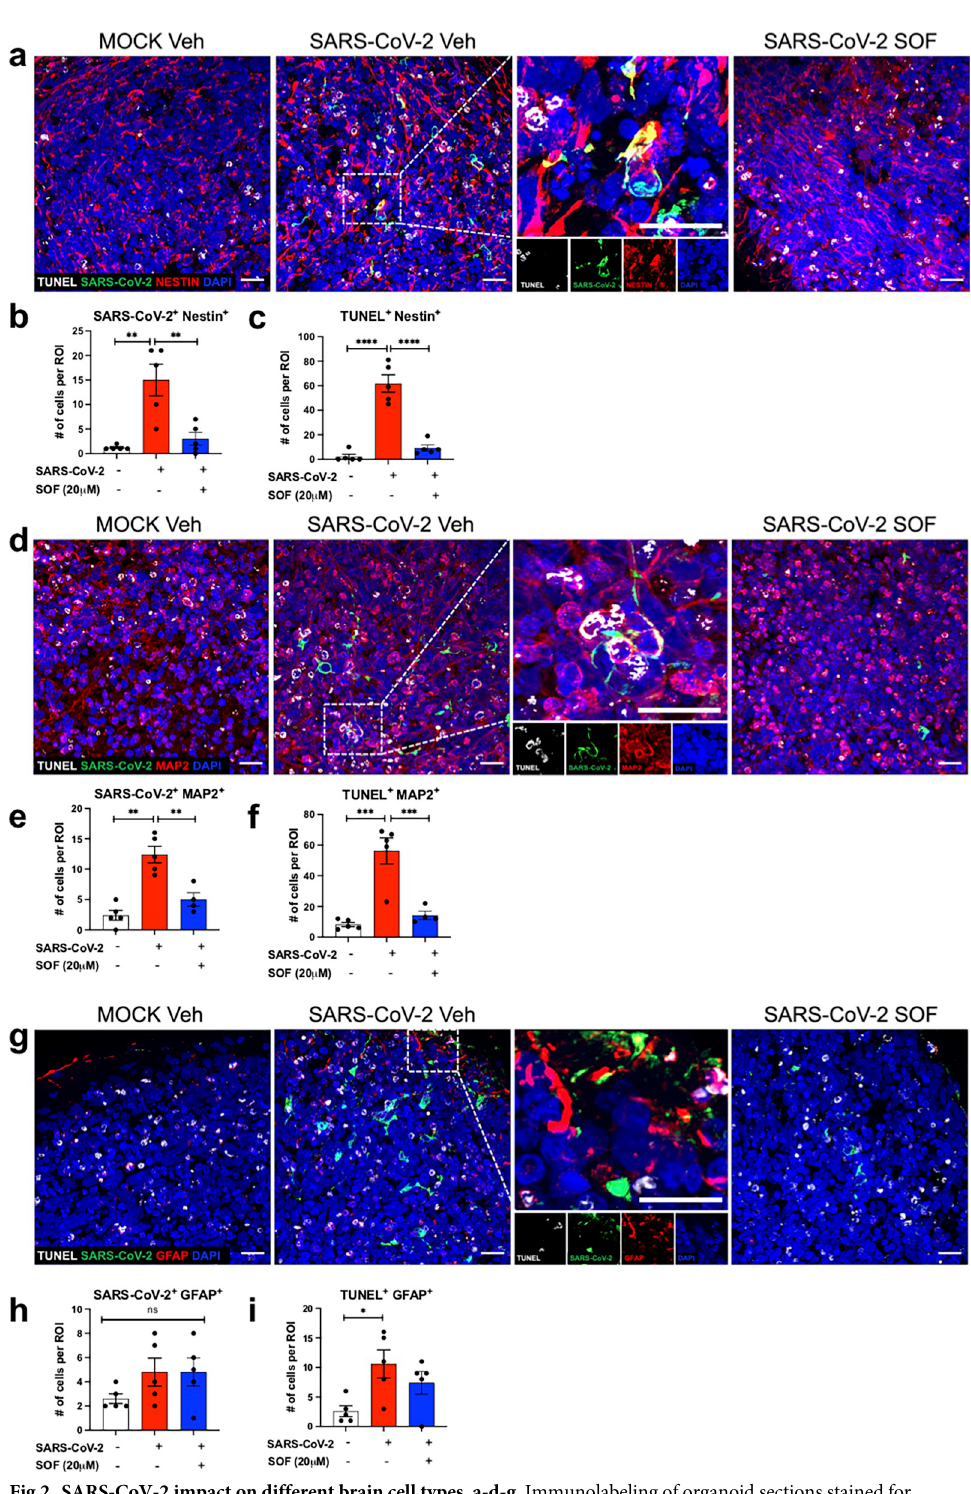
Fig 2. SARS-CoV-2 impact on different brain cell types. a-d-g . Immunolabeling of organoid sections stained for TUNEL (white), SARS-CoV-2 N protein (green), Nestin (red), GFAP (red), MAP2 (red), respectively by confocal microscopy. The insets show merged images and depict colocalization of TUNEL or SARS-CoV-2 N protein within each cell type; Nestin + NPC, GFAP + astrocytes or MAP2 + neurons. Images below each inset show split channels. Scale bar, 20 μ m n = 5 biological replicates per condition. b,c,e,f,h,i. Quantification of the number of cells that are Nestin + , MAP2